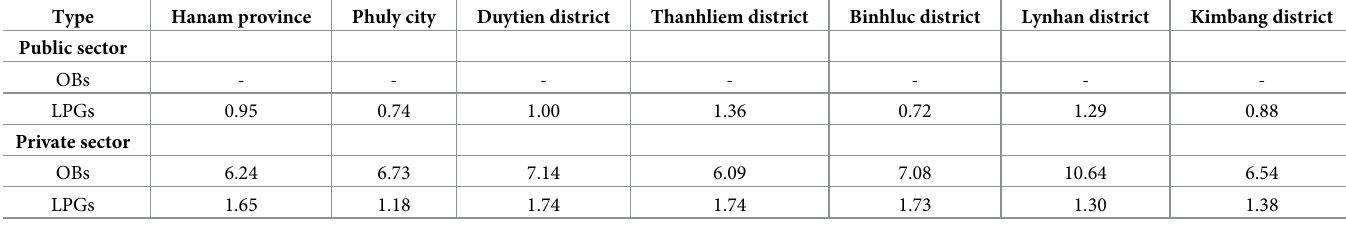
Table 5. Regional analysis: Median MPRs of EMs across the six regions surveyed.